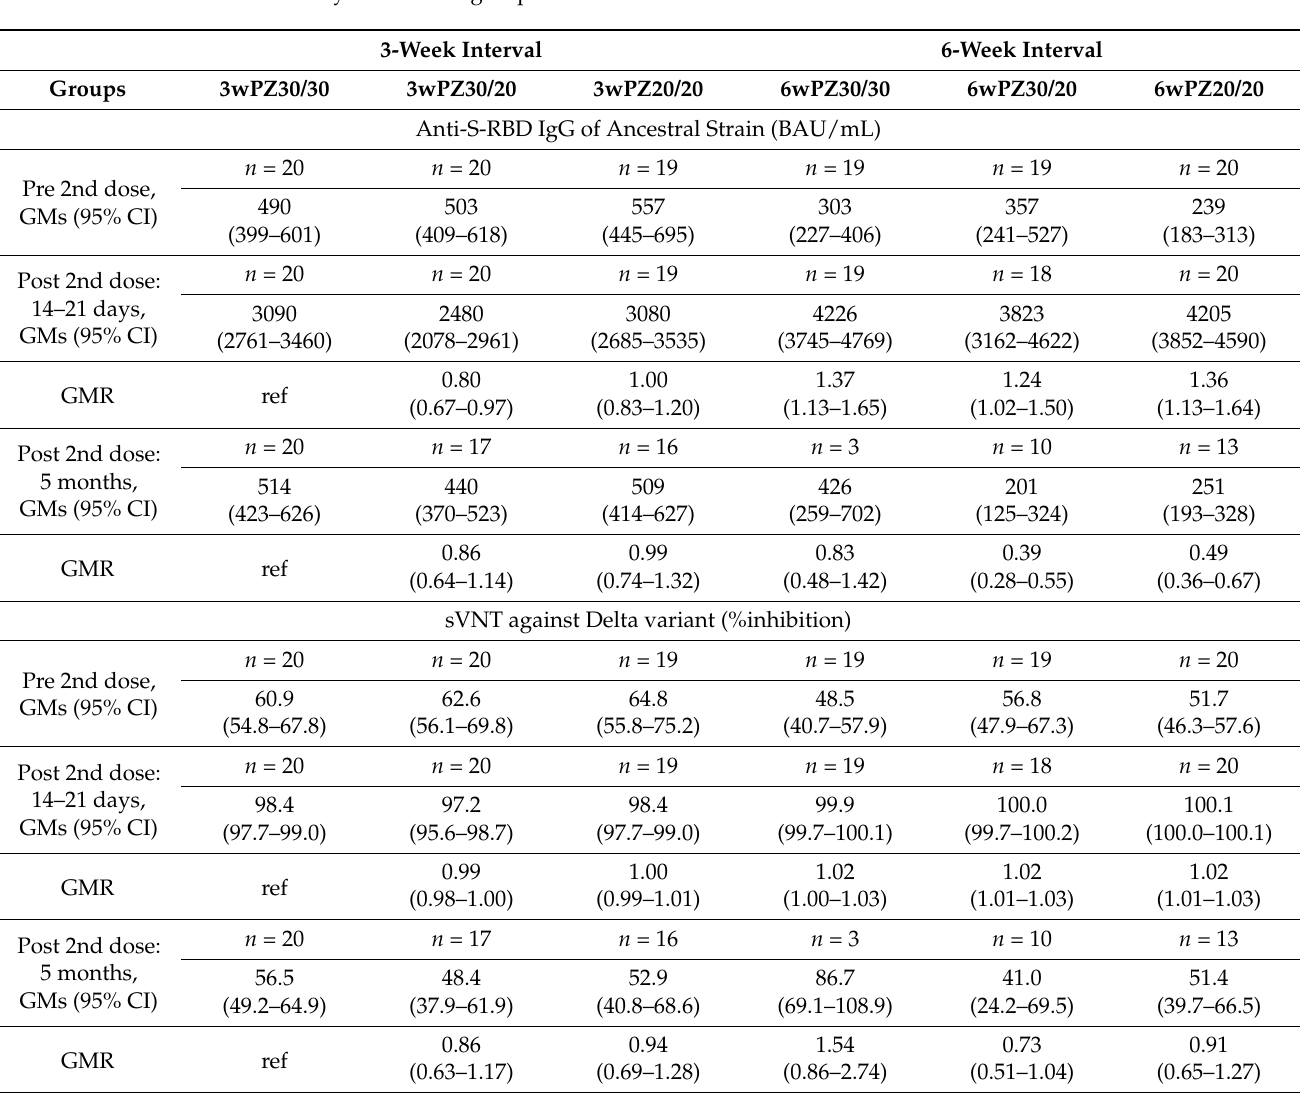
Table 1. Humoral immune response after BNT162b2 primary series vaccination in healthy adolescents by vaccination